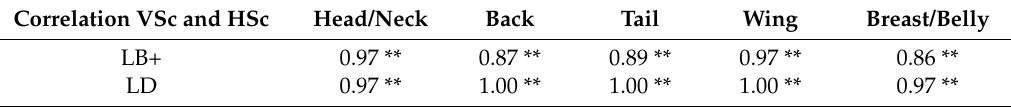
Table 4. Spearman’s rho and the level of significance for integument score comparisons between VSc and HSc methods for individual body regions in LB+ and LD laying hens throughout the laying period (21st–70th week of